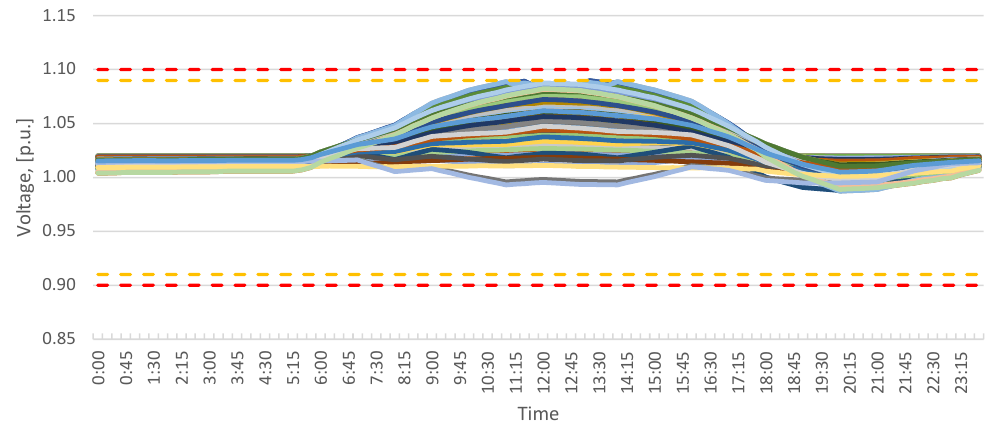
Figure 12. Inductive network voltage profiles, after the application of the LVC using all resources.